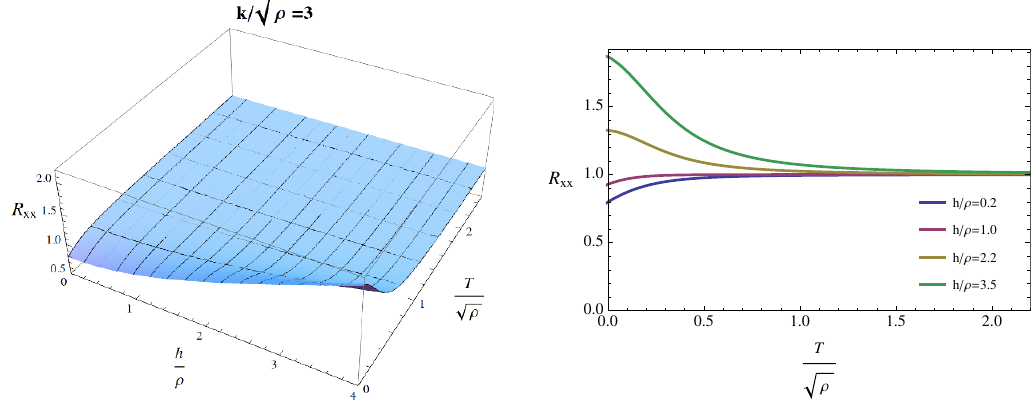
p (cid:26) . We choose the